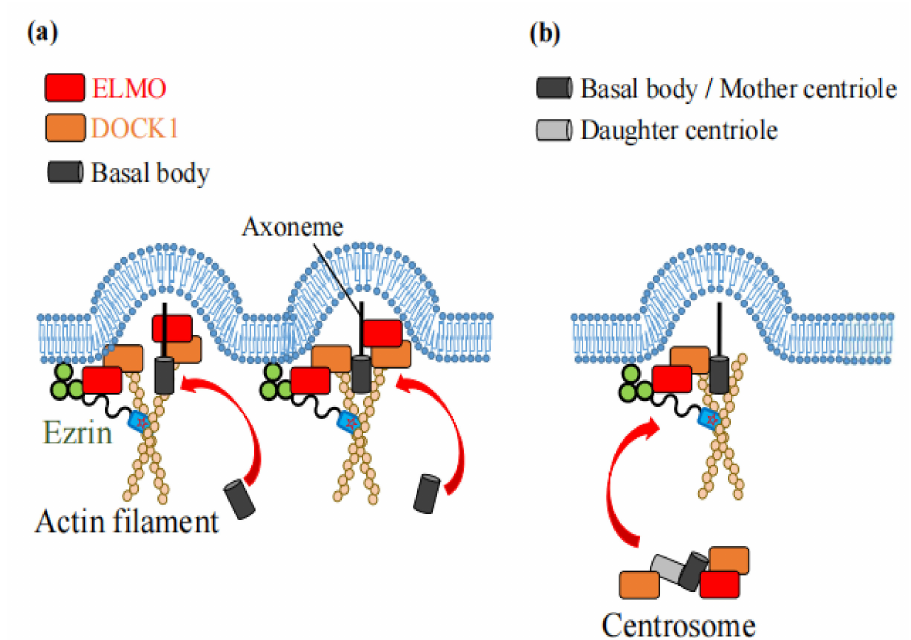
Figure 8. Ezrin functions as an F-actin binding protein for ciliogenesis. ( a ) In motile cilia, ezrin causes apical actin enrichment via interaction with actin filaments. Subsequently, the accumulation of BBs (shown by a black column) in the apical region promotes ciliary formation. Ezrin also interacts with ELMO (shown by a red box), which binds to DOCK1 (shown by an orange box). ELMO localizes along the axonemes and BBs in motile cilia. ( b ) When cells arrest in the G 0 stage of the cell cycle, BB arises from the mother centriole (shown by a black column) of the centrosome, and forms the base of the primary cilium. In primary cilia, ELMO is localized at the mother centriole, whereas DOCK1 is localized to both mother and daughter centrioles.